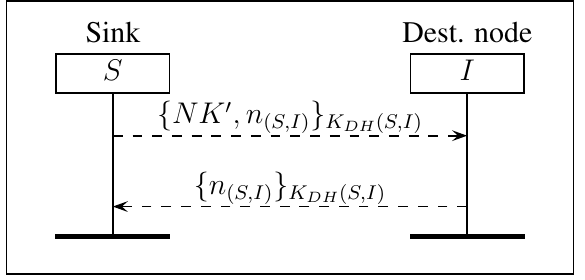
Figure 6. Protocol RNK: renewing the network